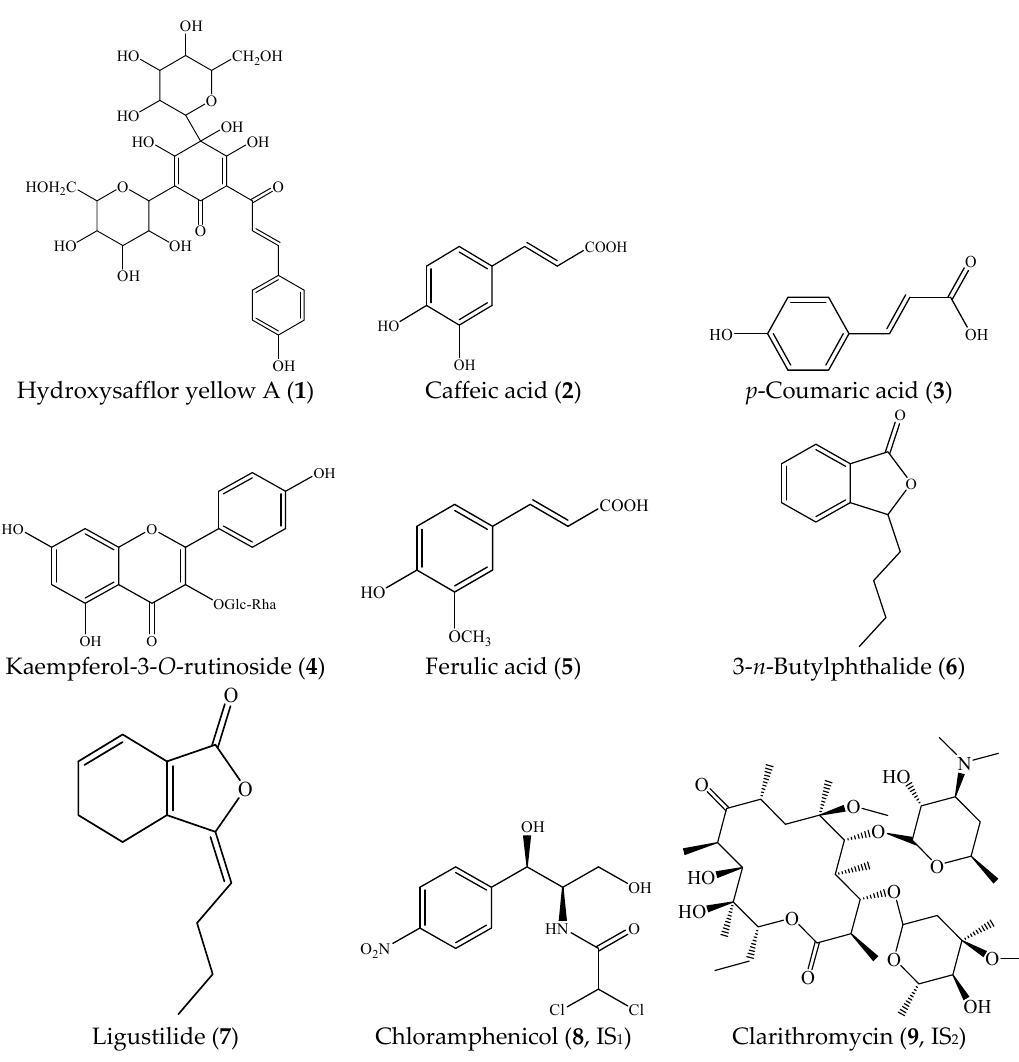
Figure 3. Chemical structures of hydroxysafflor yellow A ( 1 ), caffeic acid ( 2 ), p -coumaric acid ( 3 ), kaempferol-3- O -rutinoside ( 4 ), ferulic acid ( 5 ), 3- n -butylphthalide ( 6 ), ligustilide ( 7 ), chloramphenicol ( 8 ), and clarithromycin ( 9 ).